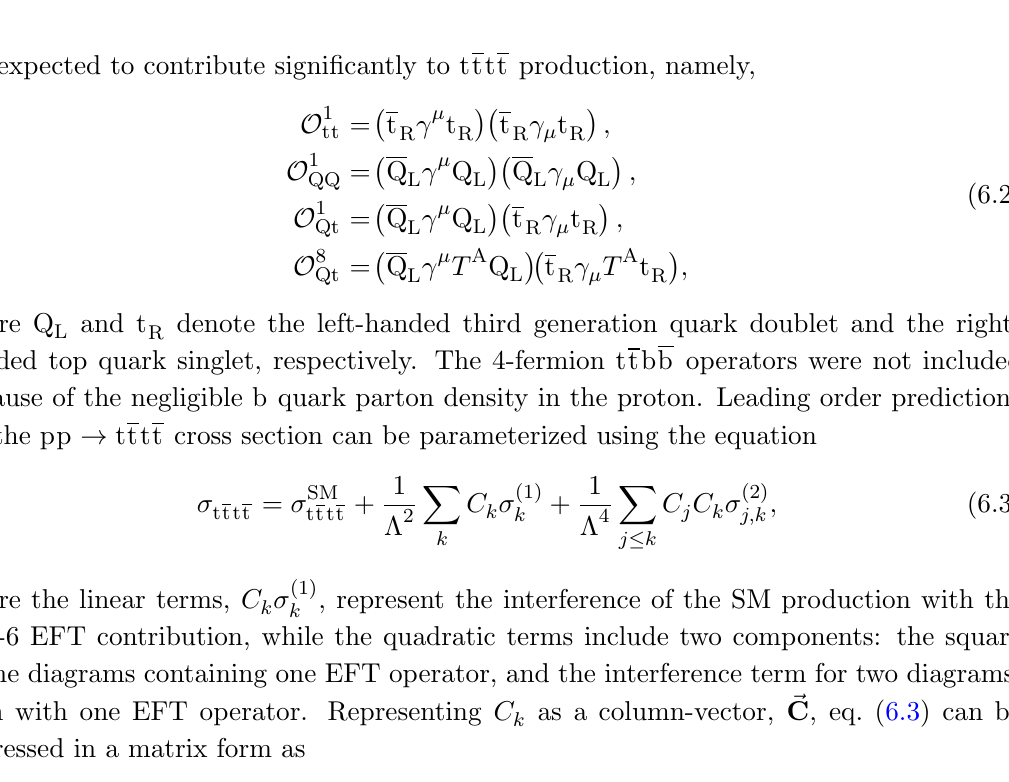
Table 4 . Linear (left) and quadratic (right) parameterization coe(cid:14)cients, (cid:27) (1) The coe(cid:14)cients (cid:27) (1)